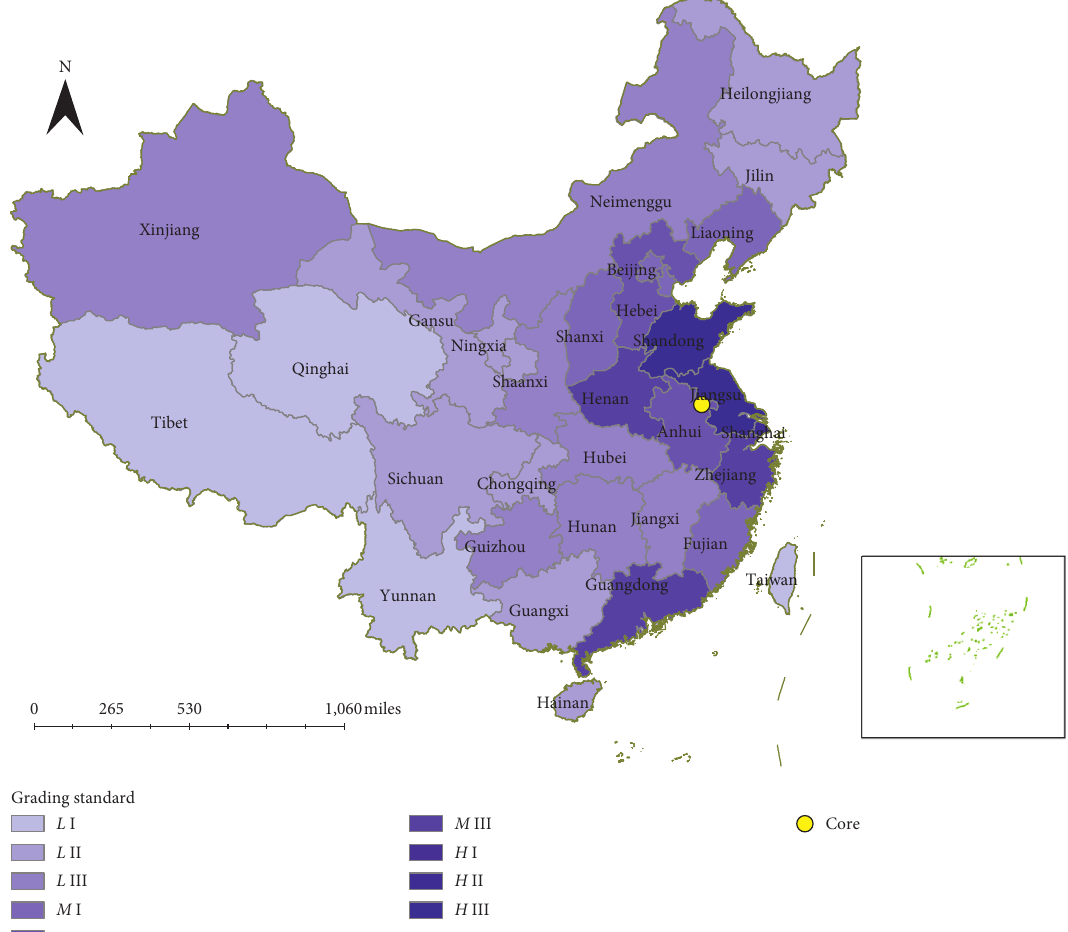
Figure 4: Depth distribution map of power carbon footprint of China’s provinces in